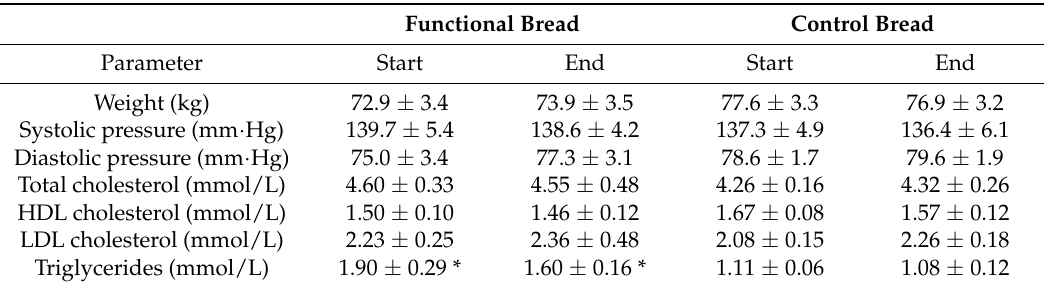
Table 4. Body weight, systolic and diastolic blood pressure, and fasting lipid concentrations, in the groups treated with either the ‘functional’ or the ‘control’ bread, before (‘start’) and after (‘end’) the observation periods. Data are expressed as means ± SE. Functional Bread Control Bread Parameter